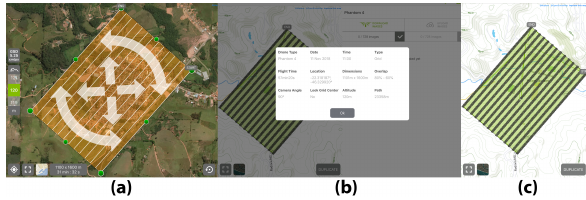
Figure 2. Data of Planning Flight. (a) flight planning. (b) project details. (c) the imaging performed.